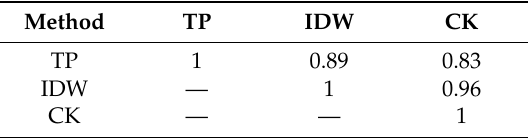
Table 5. Correlation matrix between TP, IDW, and CK in interpolating precipitation in